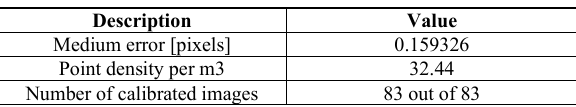
Table 4: Results values in case reconstruction case